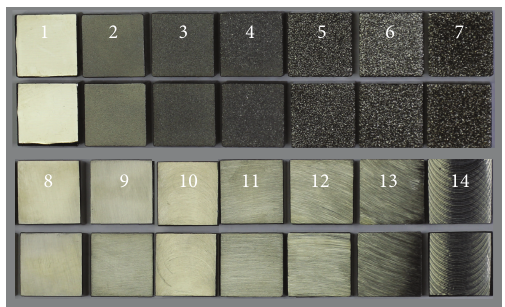
Figure 1: Analysed samples with machined